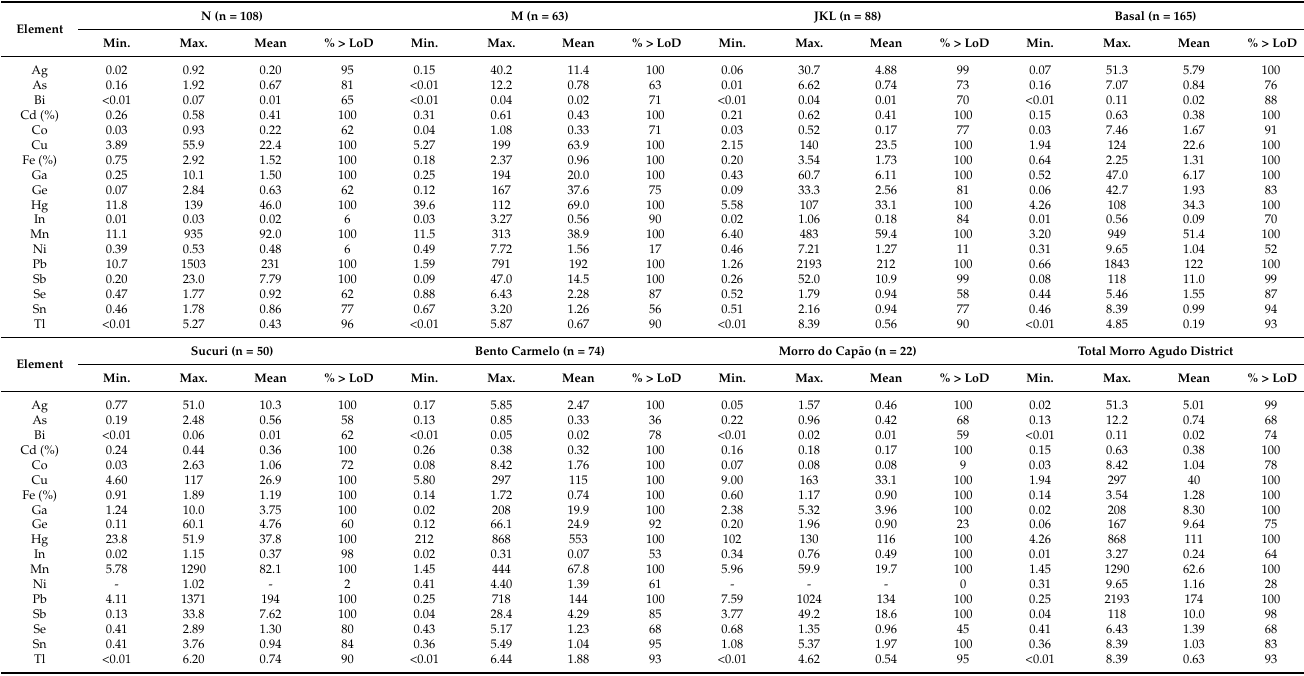
Table 2. Trace element contents of sphalerite determined by LA-ICP-MS from the Morro Agudo deposit, and Sucuri, Bento Carmelo, and Morro do Cap ã o occurrences. All units are in ppm unless otherwise stated.